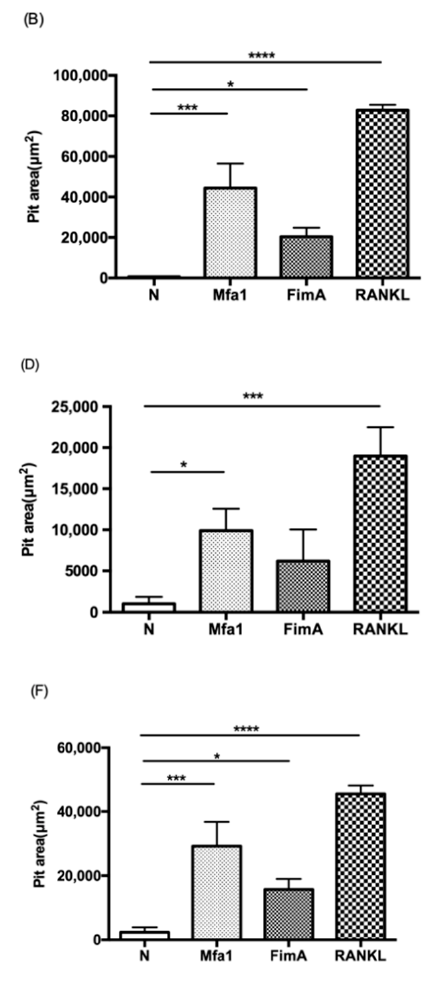
Figure 2. Effects of fimbriae on RANKL-mediated osteoclast activation. ( A , C ) RAW264 cells were prestimulated with 50 ng/mL RANKL for 24 h and then stimulated with 1 µ g/mL Mfa1 and FimA fimbriae or 50 ng/mL RANKL every 48 h. After 120 h, images of the bone slice ( A ) and Osteo Assay Stripwell Plate ( C ) were obtained. Representative images are shown for each group. White and black bars indicate 50 µ m widths. ( B , D ) Average area of pits on the bone slice ( B ) and Osteo Assay Stripwell Plate ( D ). Differences between groups were analyzed by ANOVA and Tukey’s test. Data are expressed as the mean ± SD ( n = 3). * p < 0.05, *** p < 0.001, **** p < 0.0001. ( E ) Mouse bone marrow-derived osteoclast precursor cells were prestimulated with 50 ng/mL RANKL and 25 ng/mL M-CSF for 24 h and then stimulated with 1 µ g/mL Mfa1 and FimA fimbriae or 50 ng/mL RANKL every 48 h. After 120 h, images of the bone slice were obtained. Representative images are shown for each group. White and black bars indicate 50 µ m widths. ( F ) Average area of pits. Differences between groups were analyzed by ANOVA and Tukey’s test. Data are expressed as the mean ± SD ( n = 3). * p < 0.05, *** p < 0.001, **** p <